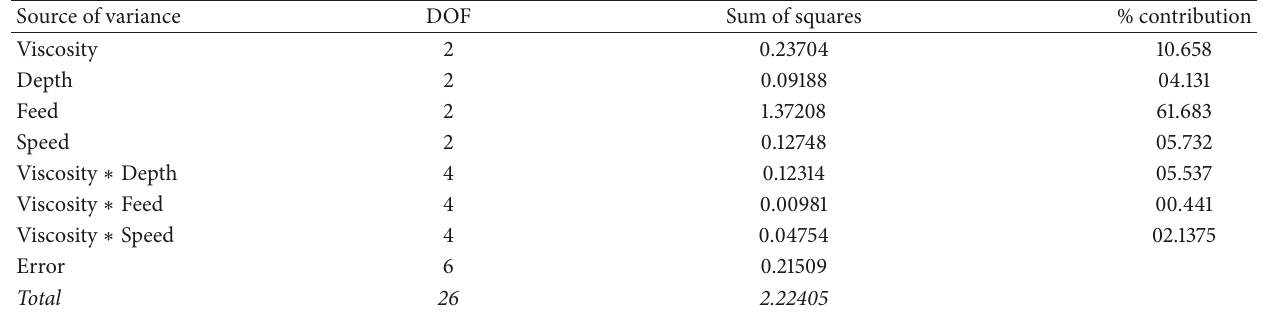
Table 6: ANOVA interfamily surface